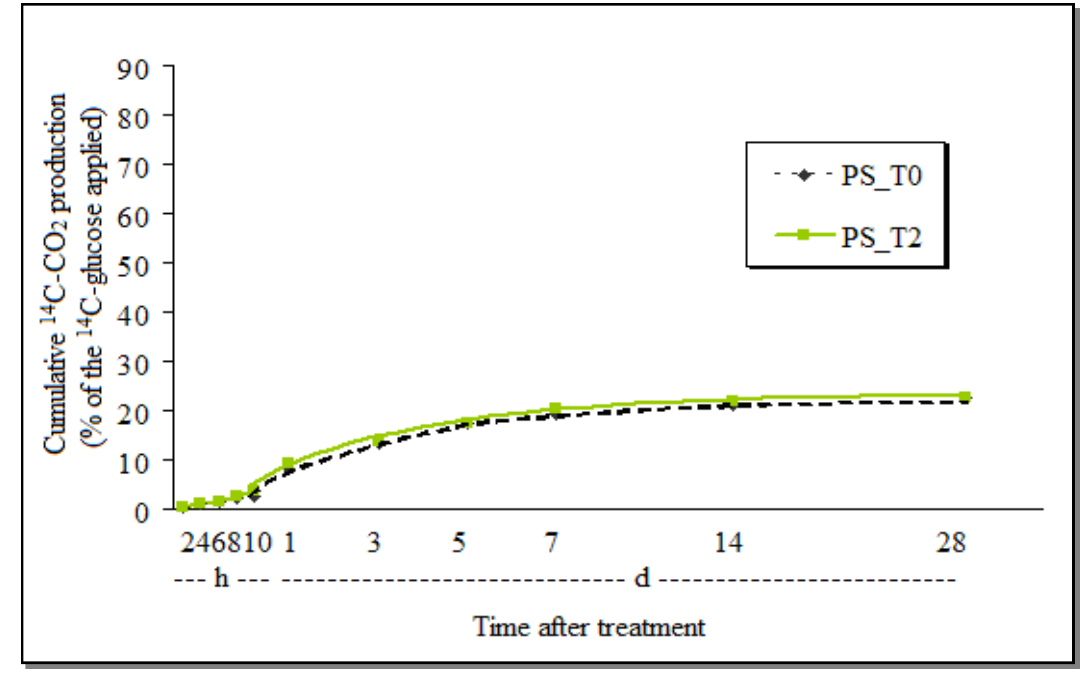
Figure 6. Cumulative production of 14 C-CO with the P. sonchifolia methanol extract (PS_T0 = control; PS_T2 = P. sonchifolia ; h = hours; d = days)